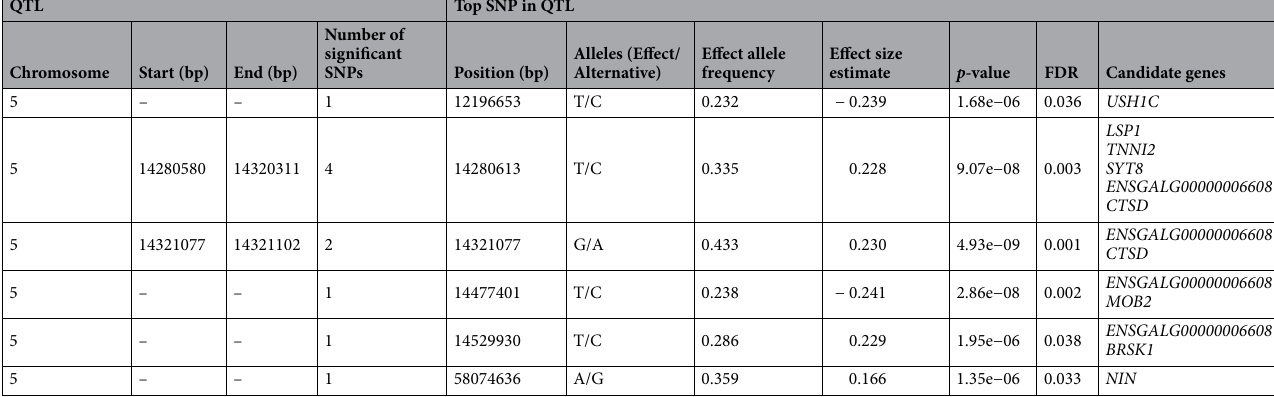
Table 5. White Striping QTL. Results of single-marker genome-wide association analysis using all progeny. Candidate genes include protein-coding genes located within 5000 bp upstream or downstream of the QTL start or end site,